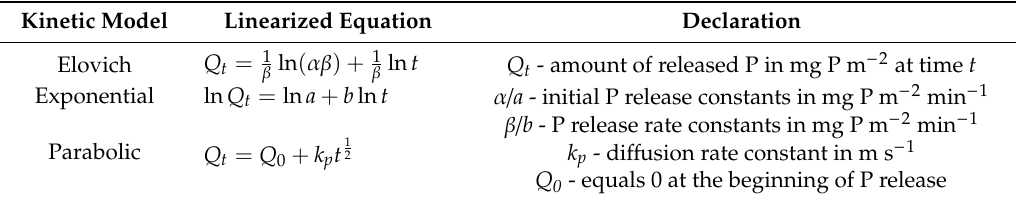
Table 1. Selected kinetic